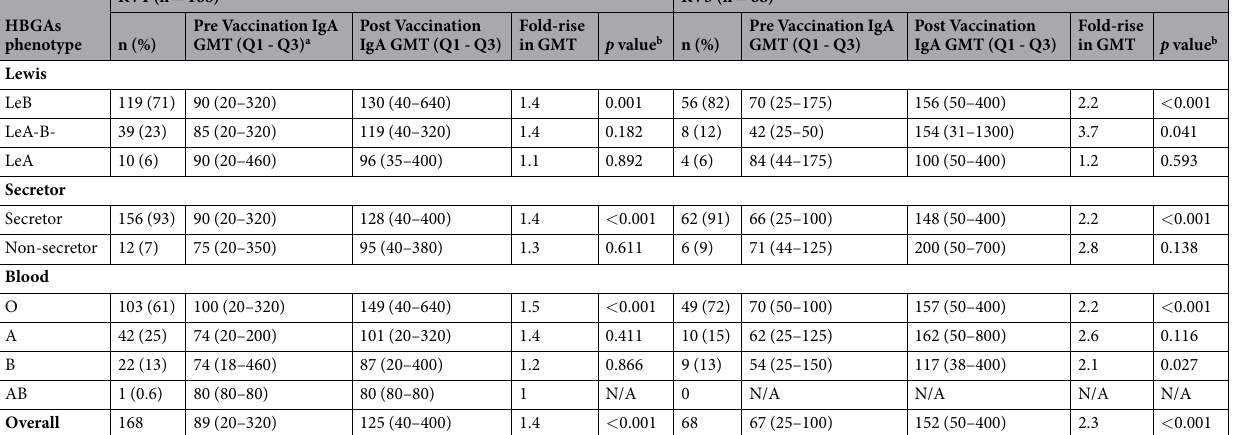
Table 2. Association of HBGA phenotypes with pre- and post-vaccination IgA titers in RV1 or RV5 vaccinated Nicaraguan children. a Q1 and Q3 stand for Interquartile 25th and 75th, respectively. b Wilcoxon Signed Ranks Test was used to compare change in rotavirus specific IgA following vaccination. Abbreviations: RV1 = monovalent rotavirus vaccine; RV5 = pentavalent rotavirus vaccine; GMT = geometric mean